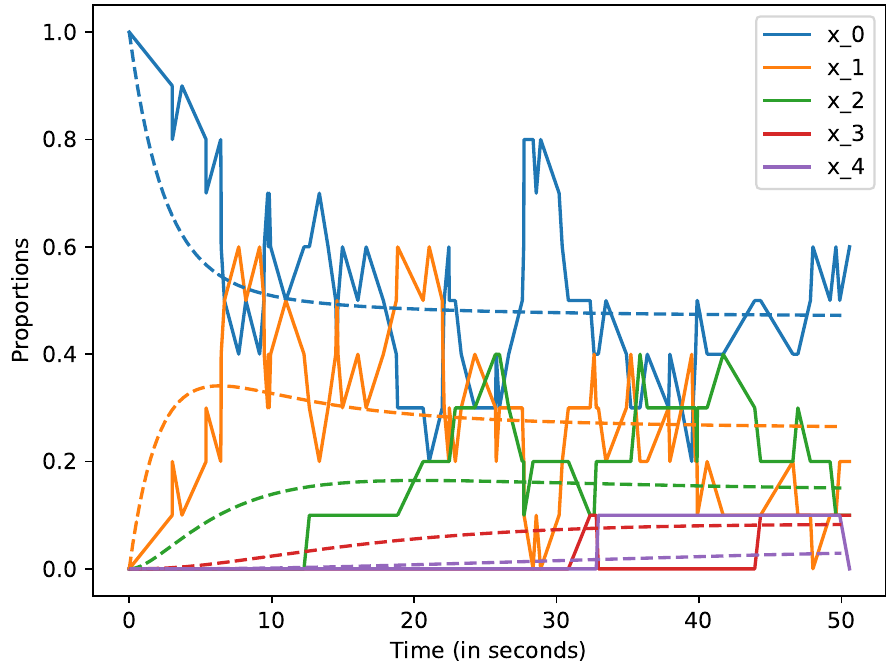
Figure 3. Mean-field approximation for N = 10 devices. Time in